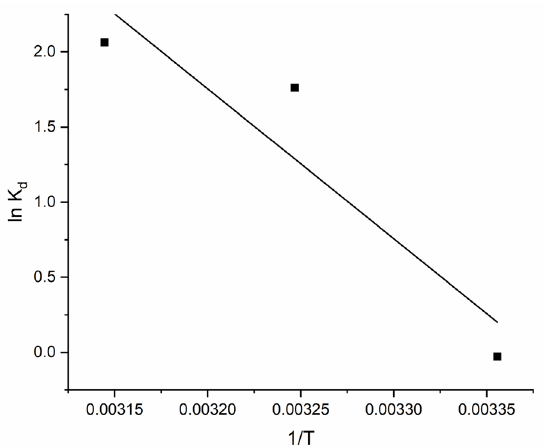
Figure 7. Thermodynamic plot ln KD vs 1/T for copper ions biosorption onto